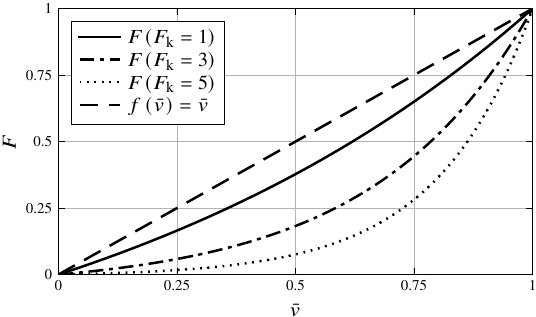
Figure 8. Influence of factor F k on filter